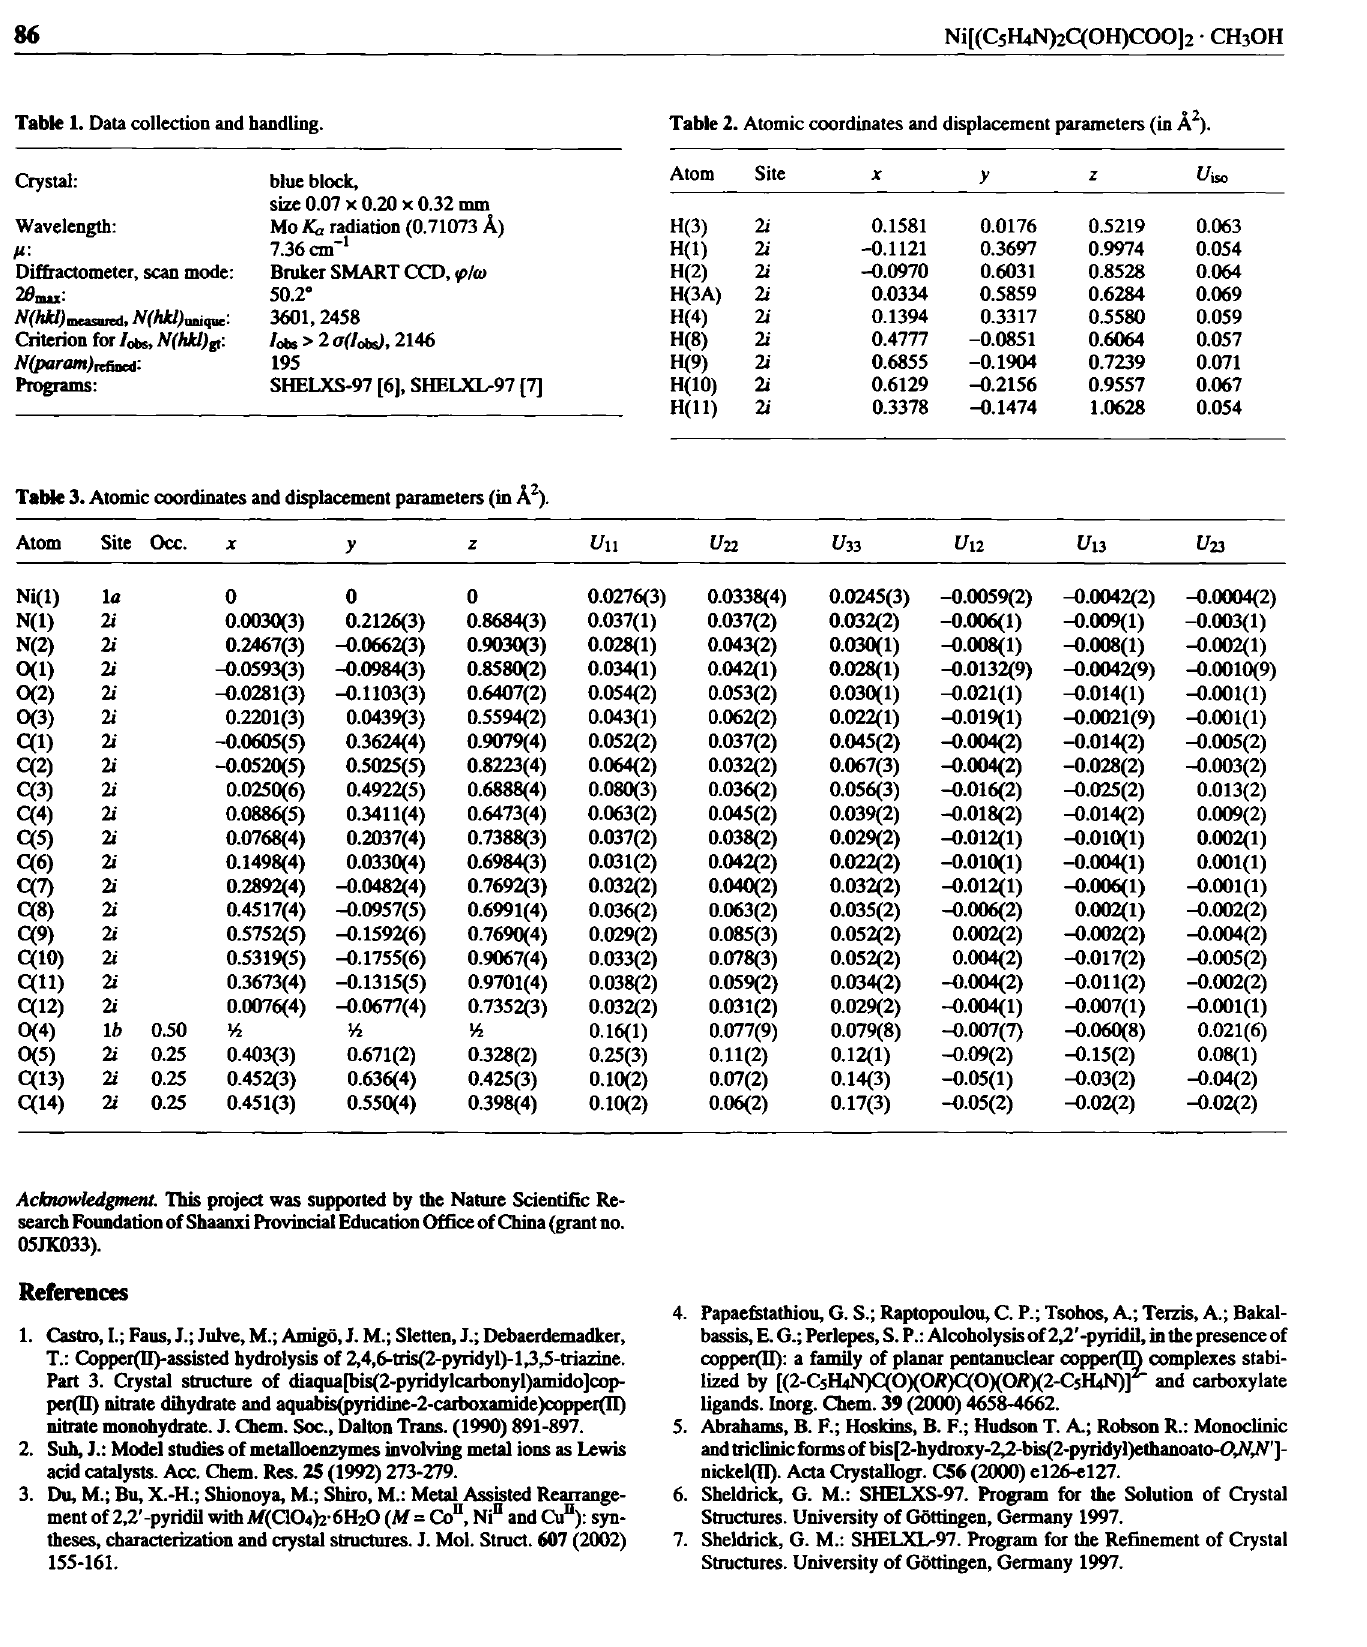
Table 3. Atomic coordinates and displacement parameters (in Ä 2